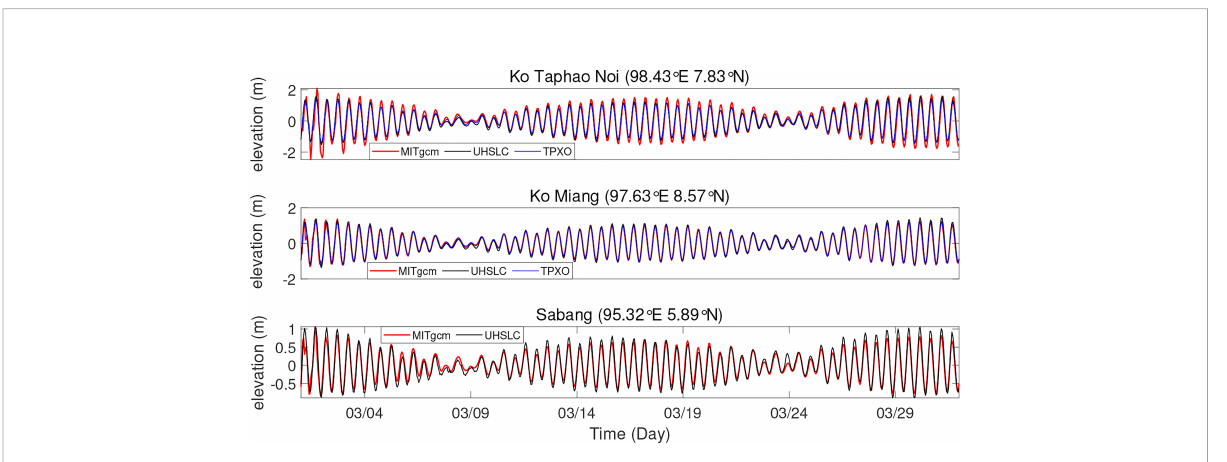
FIGURE 5 The comparisons of barotropic sea levels between model results and observations (locations are marked as red stars in Figure 1). The red line represents model-simulated elevation, the black line represents the tide gauge data from UHSLC, and the blue line represents the data of TPXO8 from 1 March to 31 March.